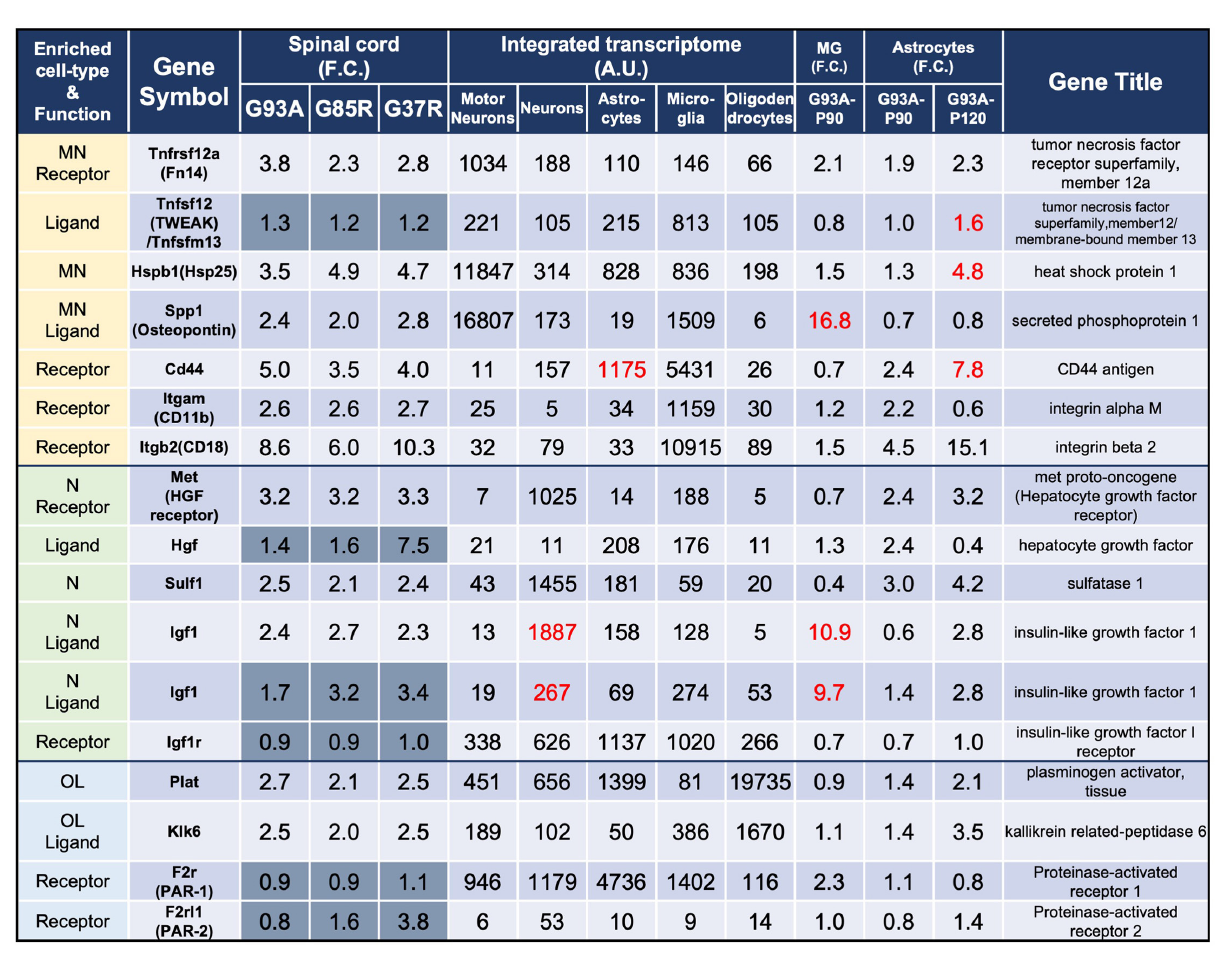
FIGURE3 Representative motor neuron-enriched genes, neuron-enriched genes, and oligodendrocyte-enriched genes in 207 DEGs were analyzed using the integrated transcriptome and SOD1 G93A cell-type transcriptome. The 3rd to 5th columns show the fold changes in each gene expression in SOD1 G93A , SOD1 G85R , and SOD1 G37R mouse spinal cords compared to control samples, respectively. Genes with dark gray backgrounds in the 3rd to 5th columns that indicate fold changes (F.C.) are not included in the 207 DEGs. The 6th to 10th columns show the integrated transcriptome. The 11th column shows the fold change in expression of each gene in P90 SOD1 G93A microglia relative to control microglia. The 12th to 13th columns show the fold change in expression of each gene in SOD1 G93A astrocytes (P90 or P120) relative to control astrocytes. MN, motor neurons; N, neurons; MG, microglia; OL,